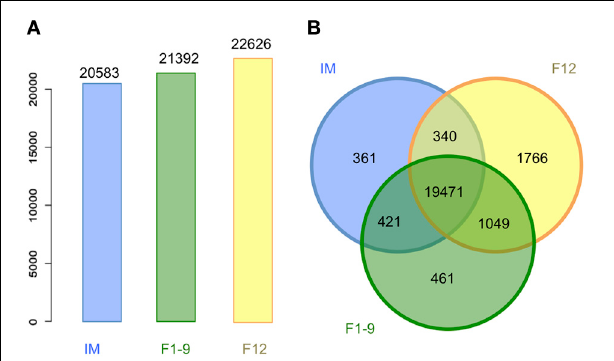
FIGURE 2 | Genes predicted based on RNA-Seq analysis for three floral developmental stages. (A) Number of highly confident genes expressed in each stage. (B) Unique and shared genes among three developmental stages. IM represents inflorescent meristem, F1–9 for flower development stage 1–9, F12 for flower development stage 12.